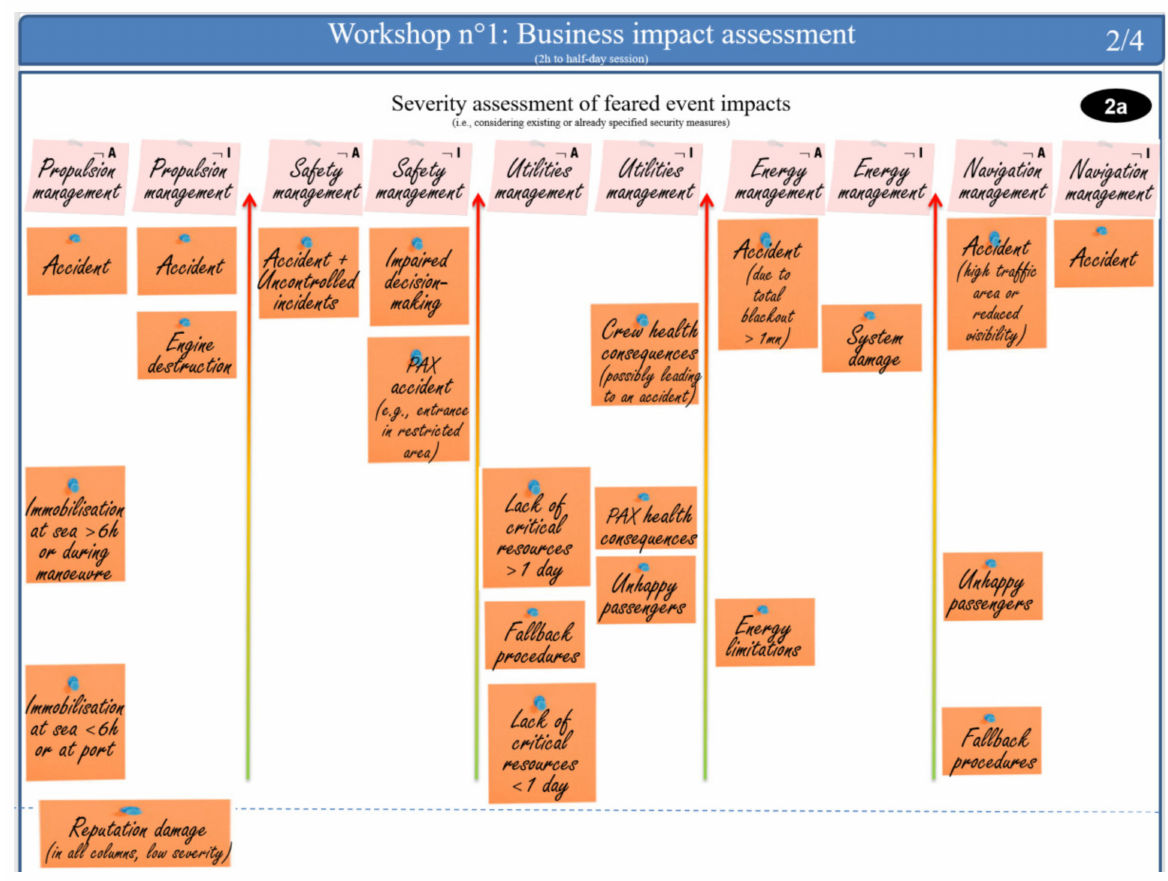
Figure 5. Naval use case—business impact